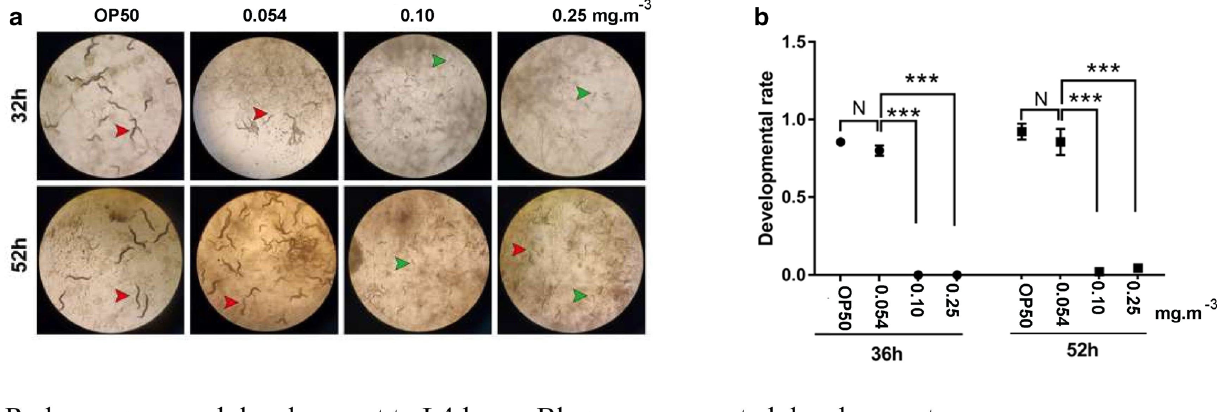
Figure 6. Development of Caenorhabditis elegans fed with bacteria collected at 12 weeks. Picture of Caenorhabditis elegans development ( a ); comparation of development rate fed with bacteria from